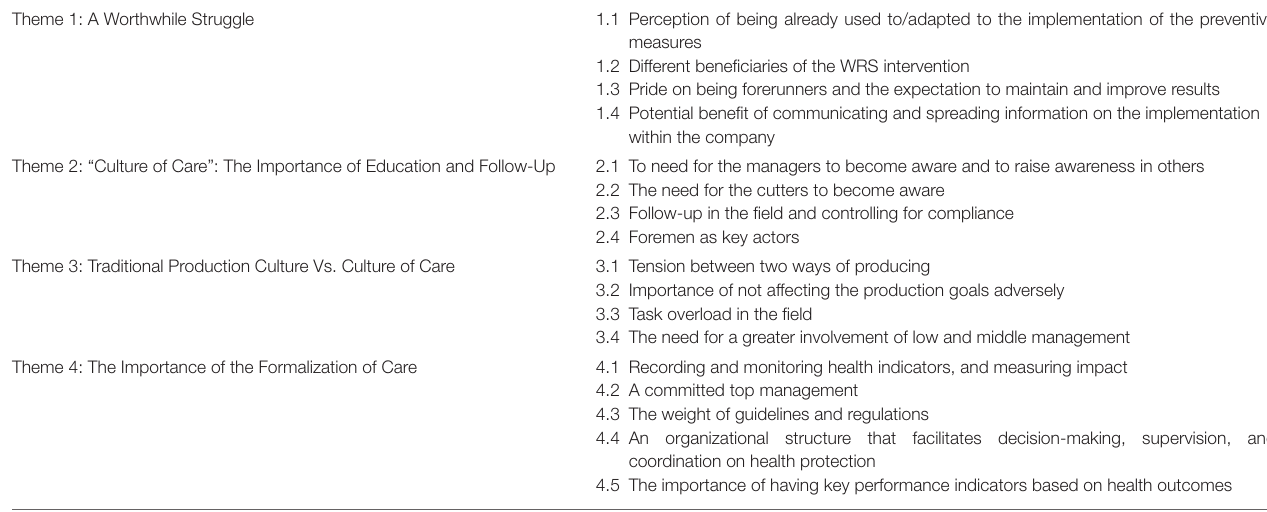
TABLE 1 | Clustered themes and